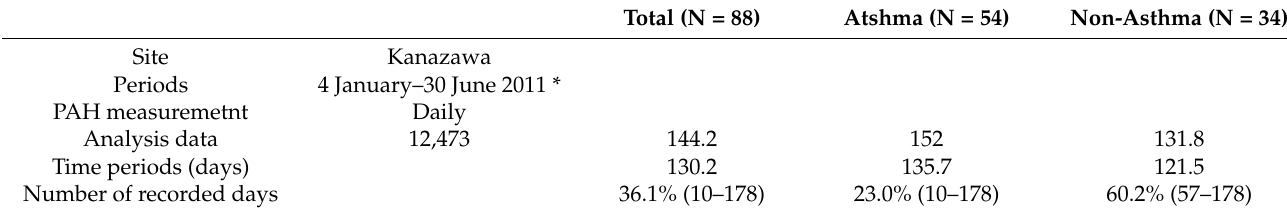
Table 1. Summary of data set.